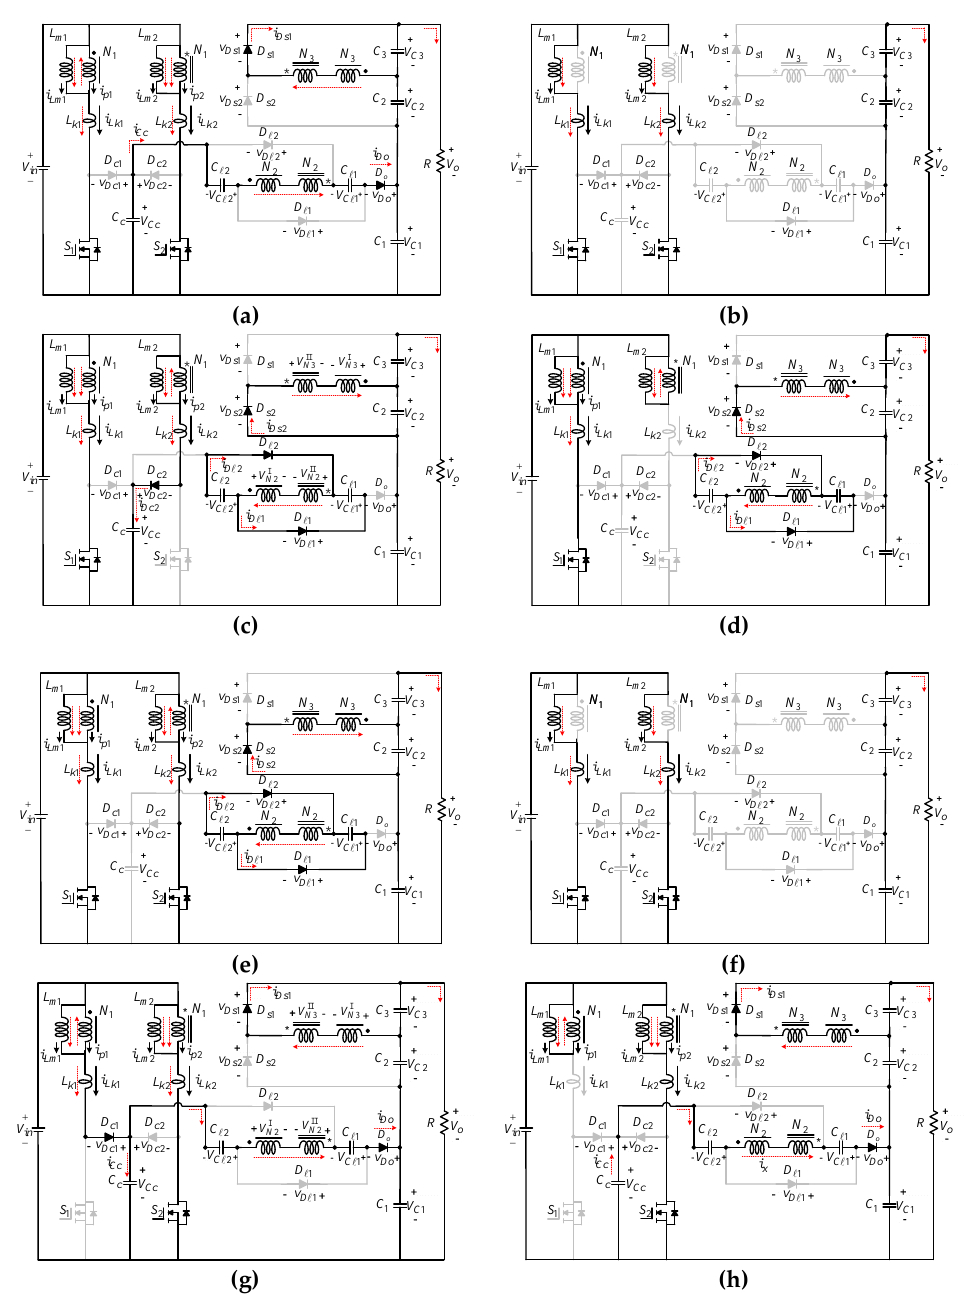
Figure 4. Operating stages of the proposed converter. ( a ) Stage 1, ( b ) Stage 2, ( c ) Stage 3, ( d ) Stage 4, ( e ) Stage 5, ( f ) Stage 6, ( g ) Stage 7, ( h ) Stage 8.